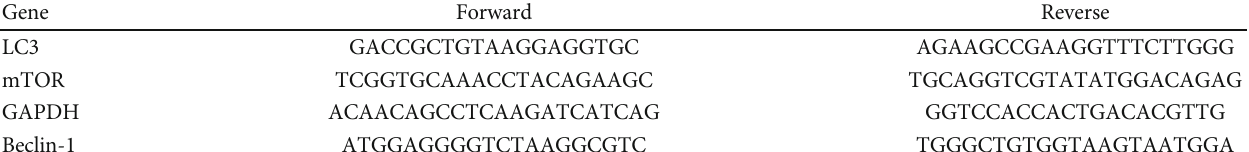
Table 1: Primer sequences used in this study.